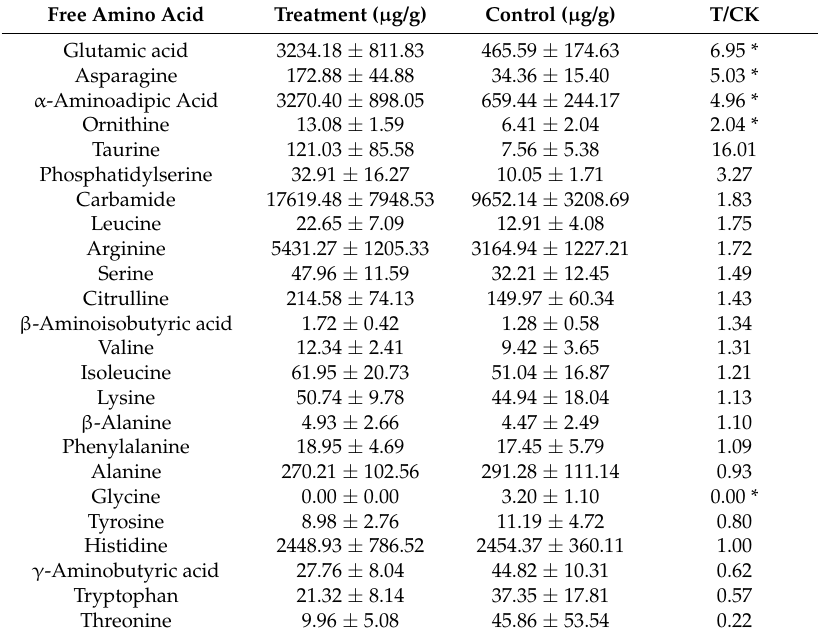
Table 2. Effect of PGR on free amino acids in C. Radix